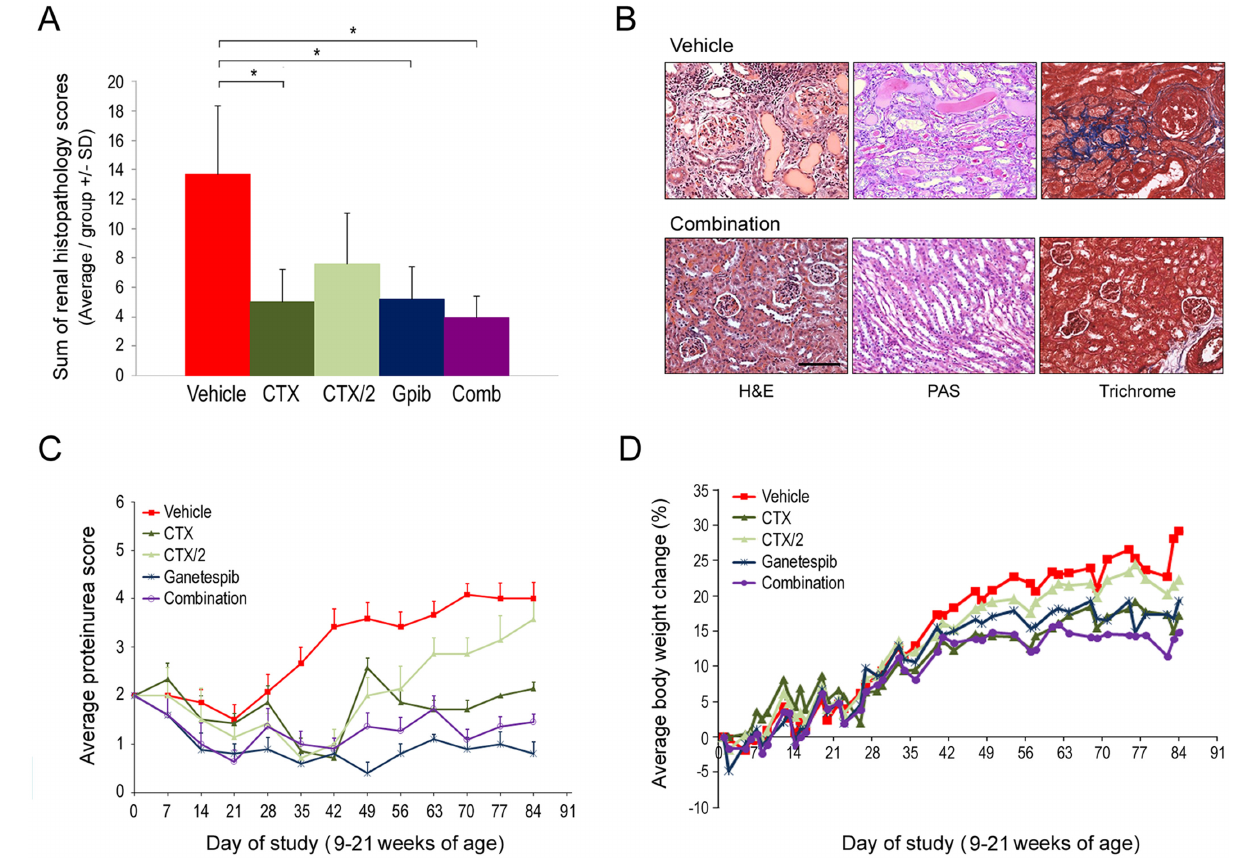
Fig 3. Comparative efficacy and tolerability of ganetespib and cyclophosphamide therapy in preventing glomerulonephritis progression using a therapeutic dosing regimen. (A) Composite renal disease scores. The average summed pathology scores for each treatment group are plotted ( ± SD). * p < 0.05. Gpib , ganetespib; Comb , combination . (B) Representative renal histopathology from vehicle- and combination (ganetespib + CTX/2)-treated animals at the end of the study. In contrast to the kidneys from control animals which displayed marked glomerular crescent formation, chronic inflammation, tubular casts by PAS staining, and extensive fibrosis as evidenced by trichrome stain, combination treatment maintained near-normal glomerular and tubular architecture. Original magnification, 20X; scale bar represents 100 μ m. (C) Serial measurements of urine protein were performed in individual mice and average proteinuria scores ( ± SE) are plotted for each treatment group. (D) Body weights were measured 3 – 4 times per week. Average percentage weight changes for each treatment group are shown.